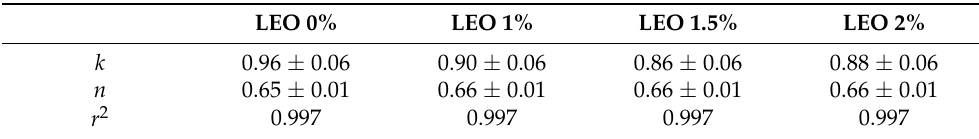
Table 1. Consistency index ( k ) and flow index ( n ) of alginate/lemongrass essential oil (LEO) nanofor- mulations obtained from the fitting with power law.